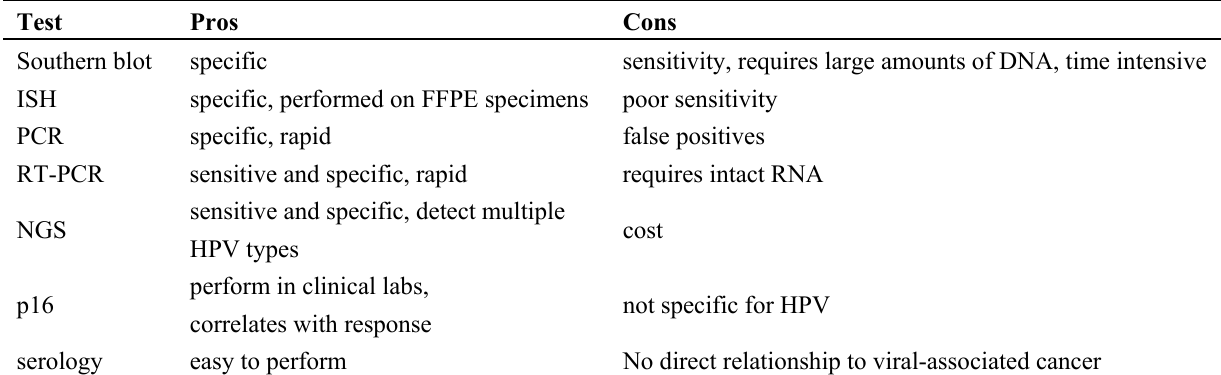
Table 1. Pros and cons for tests of HPV